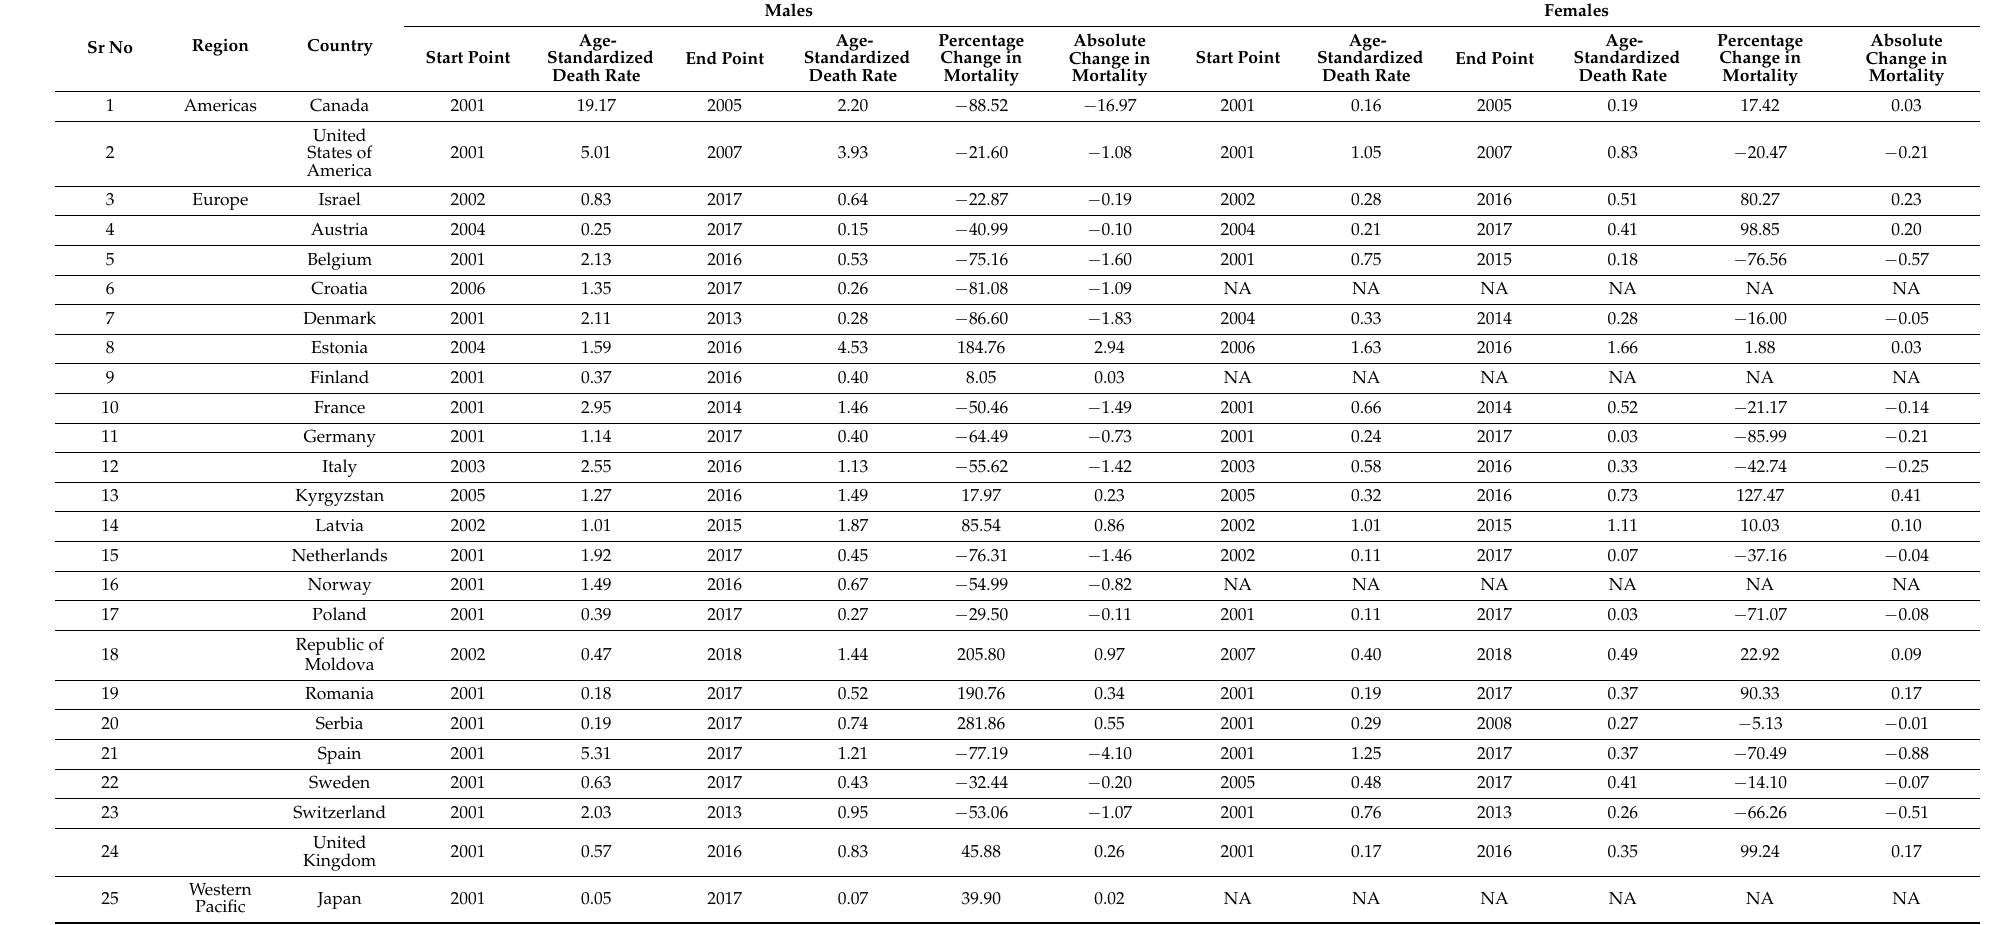
Table 1. Age-Standardized Death Rate during the start and end points of the